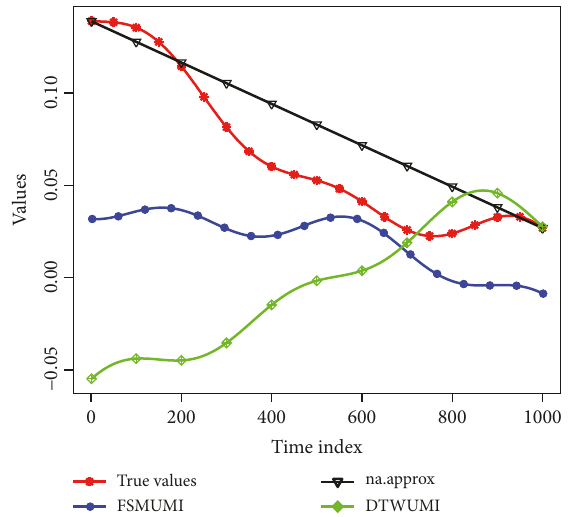
Figure 4: Visual comparison of completion data of different imputation approaches with real data on the 1 𝑠𝑡 signal of synthetic series with the gap size of